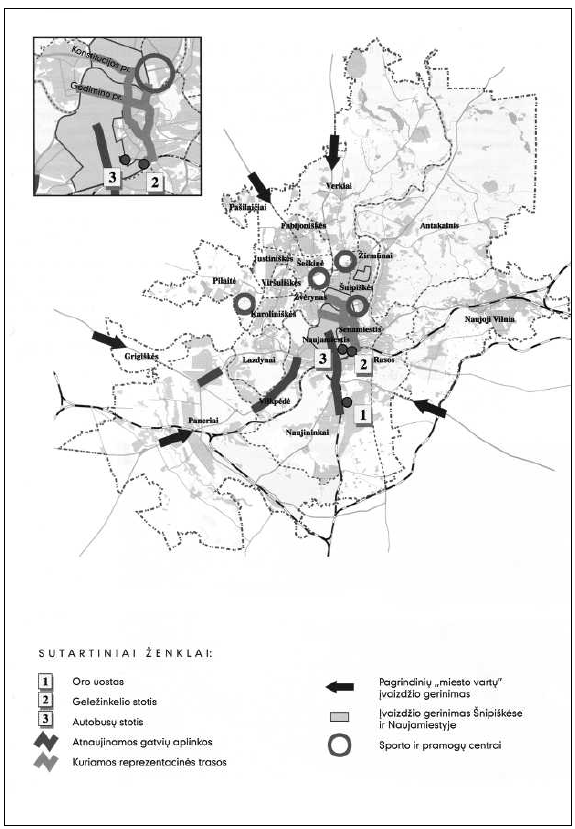
Fig 13. Study on urban formation of approaches to Vilnius city (“city gate”). (Department of Urban Design in VGTU, 2003. Theme supervisor – Prof A. Vyšniūnas)